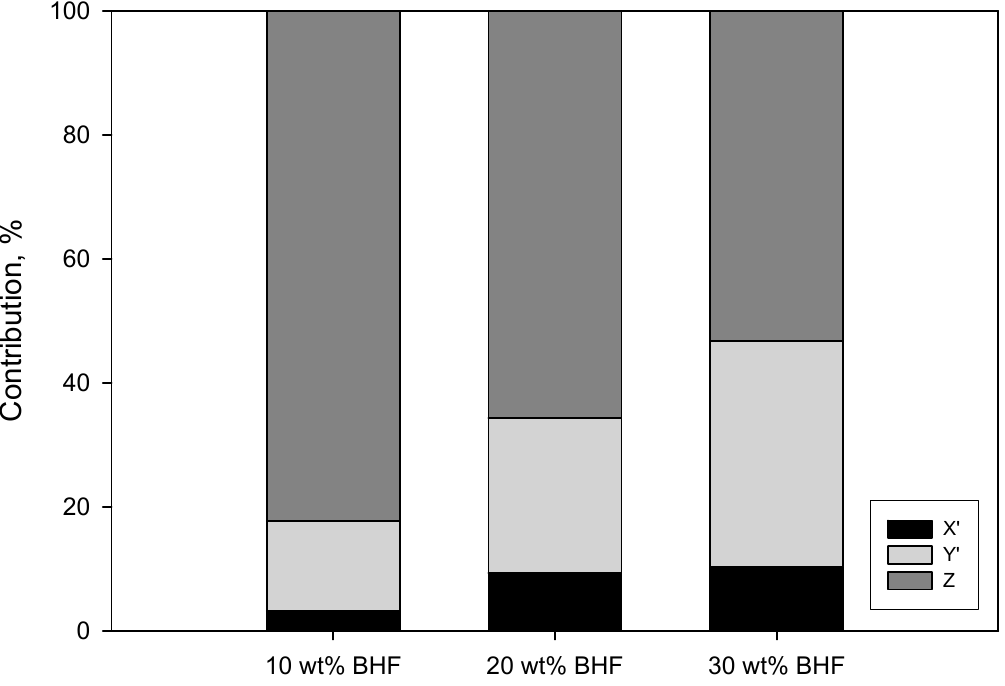
Figure 7. Percentage contributions of the phases of the composite to its tensile strength. Z is the matrix contribution to the tensile strength of composite, X’ is the subcritical fibers contribution and Y’ the supercritical fibers contribution.